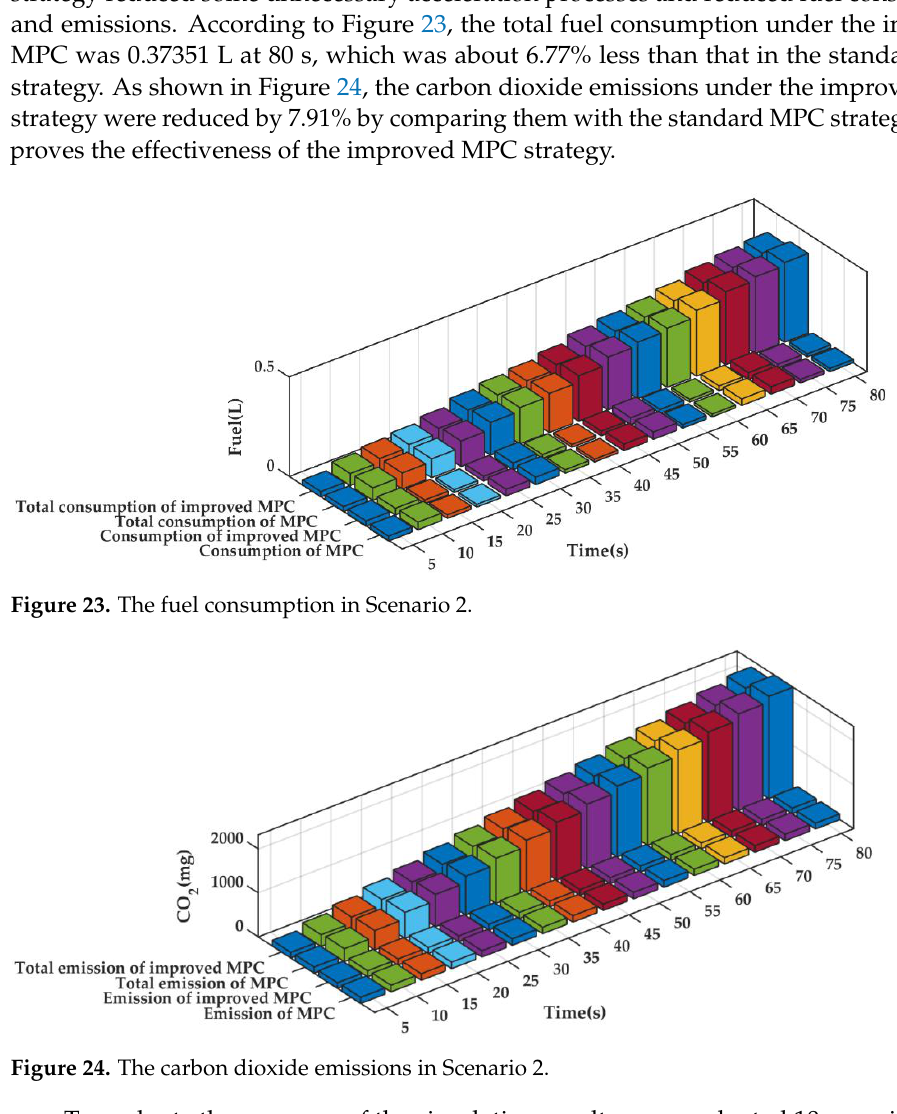
Figure 22. The positions of the following vehicle under the improved MPC strategy in Scenario 2.